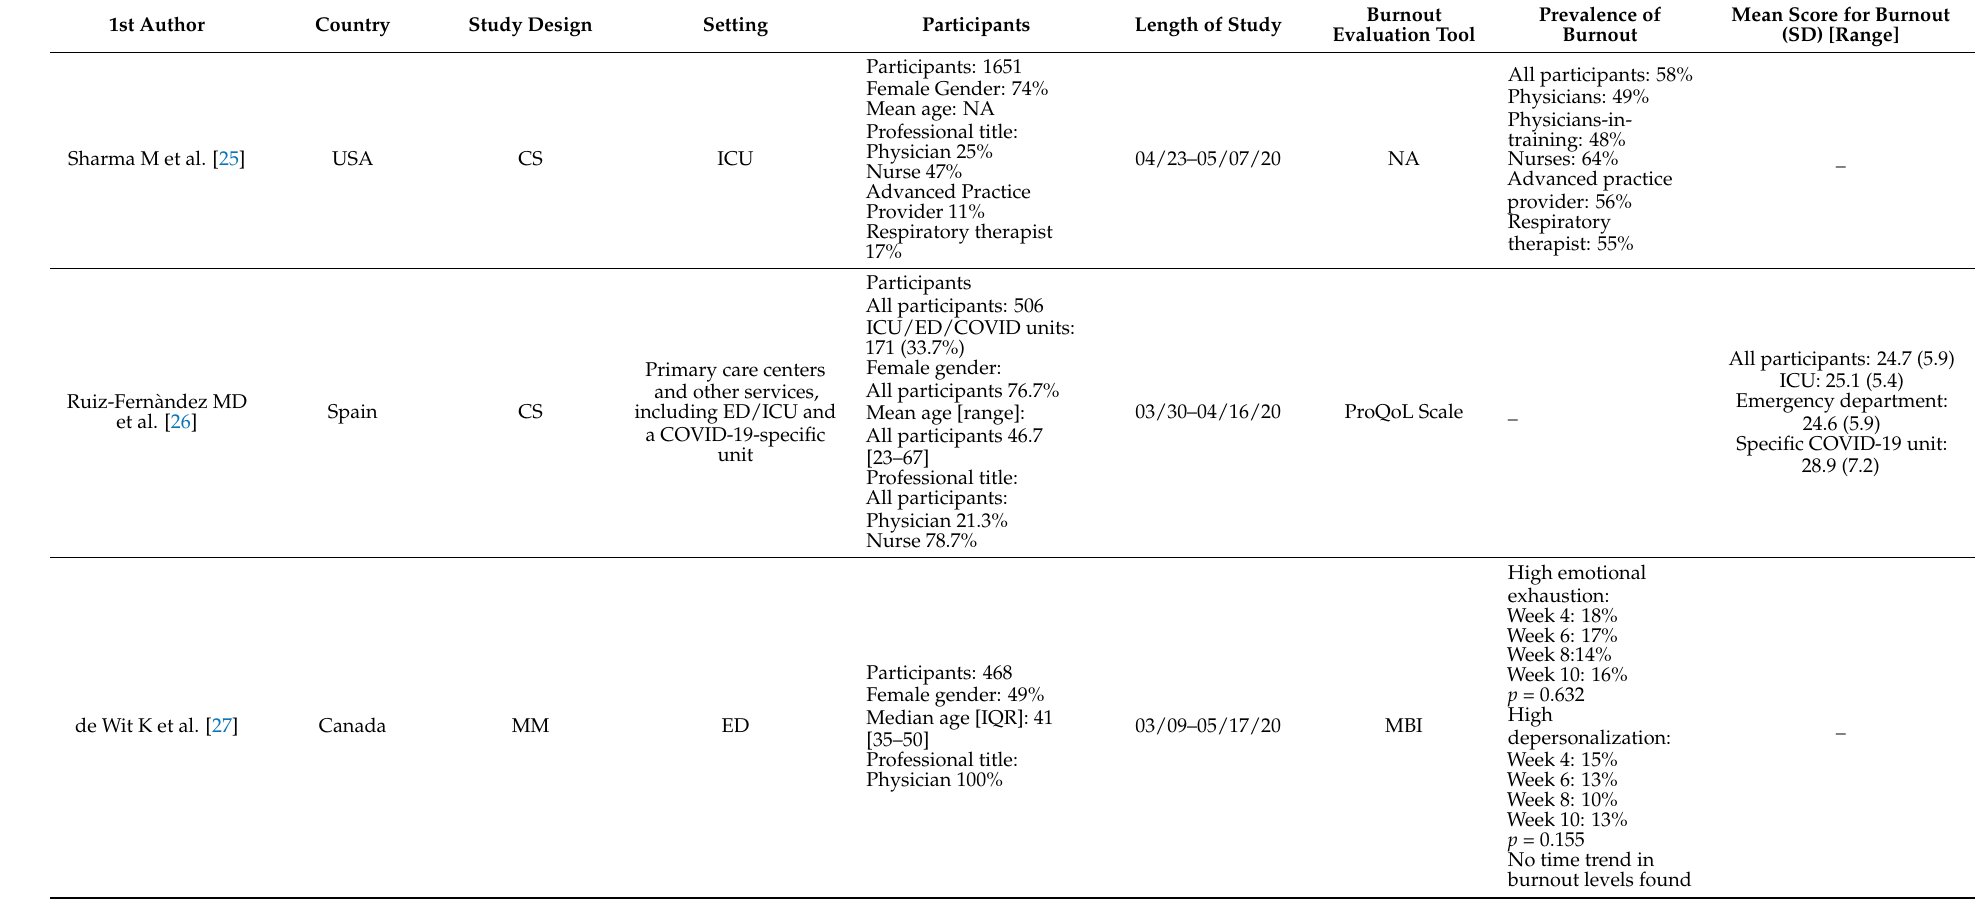
Table 2. Systematic review on burnout among professionals working in intensive care units and emergency departments: selected